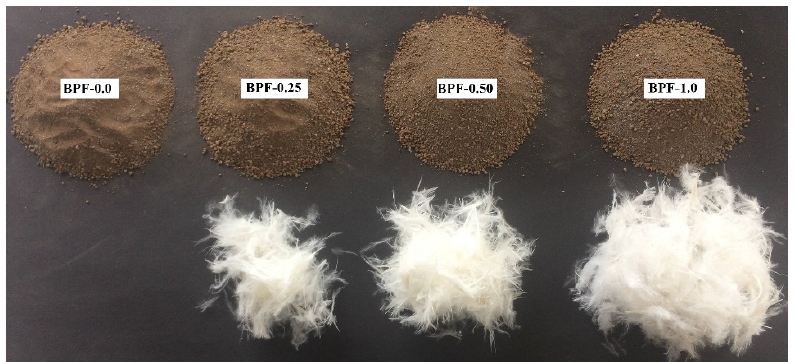
Figure 5. Proportions of oven-dry BPFs and oven-dry clayey soil of each earthen mix.